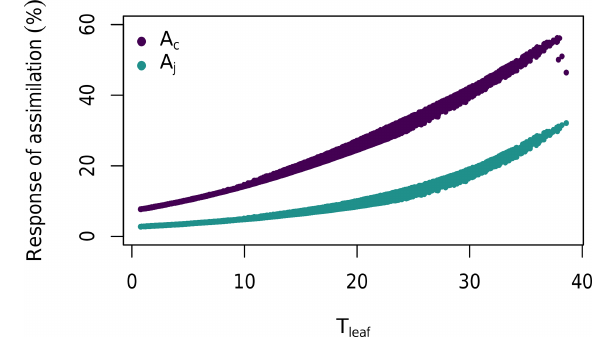
Figure 4. The response of photosynthesis to e C a on different scales and limited by different factors. In summary, from top to bottom, the figure demonstrates how a large increase in leaf photosynthesis can diminish into a statistically nonsignificant change in the canopy GPP under e C a . Entries from top to bottom are as follows: (a) A inst is the instantaneous response of leaf photosynthesis to e C a obtained from A - C i measurements in ambient rings (error bars indicate 95% CI); (b) A c is the modelled response of Rubisco-limited leaf pho- tosynthesis, assuming no downregulation, averaged over the range of diurnal air temperatures experienced during the experimental pe- riod; (c) A J is the modelled response of RuBP-regeneration-limited leaf photosynthesis; (d) GPP inst is the direct effect of e C a on the canopy GPP, modelled with MAESPA, assuming no downregula- tion of photosynthesis and averaged across all six rings; (e) A long is the long-term response of leaf photosynthesis to e C a obtained from leaf photosynthesis measured at treatment CO 2 concentrations (see Ellsworth et al., 2017) – this value is different from A inst because it incorporates photosynthetic acclimation; (f) GPP long is the effect of e C a on the canopy GPP once the measured downregulation of V cmax is taken into account; (g) LAI is the measured difference in the average LAI between e C a and ambient C a rings over the exper- iment period (data from Duursma et al., 2016); and (h) GPP field is the GPP response modelled with MAESPA comparing the three el- evated rings with the three ambient rings. The bars represent model outputs, and points represent observations. See the text for further explanation.